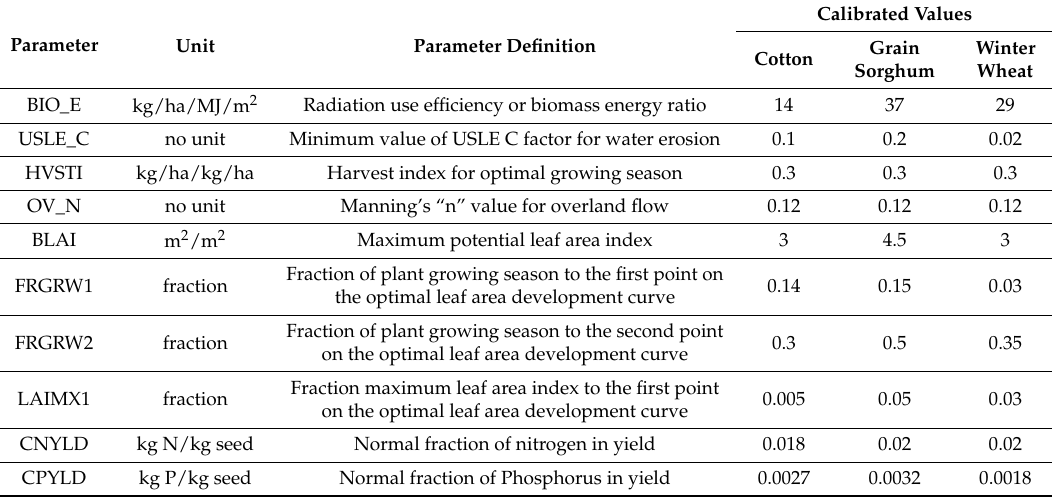
Table 2. Cotton, grain sorghum, and winter wheat yield calibration parameters.